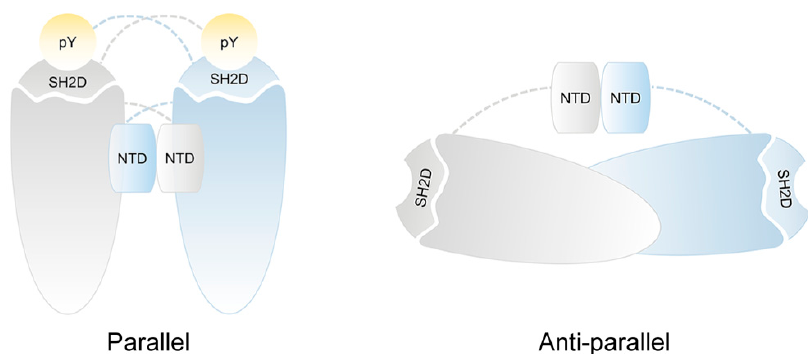
Figure 2. Schematic representation of STAT1 and STAT3 dimeric structure. The cartoon illustrates the proposed dimer conformations for STAT1 and STAT3 dimer: parallel and anti-parallel form. Phosphorylated STAT1 and STAT3 dimerize in parallel form by reciprocal interactions between phosphotyrosine residues and SH2D domains. Non-phosphorylated STAT1 and STAT3 dimers have an anti-parallel orientation of the bodies with SH2D domains on the opposite end of the dimers and the NTD domains lodged between monomer.